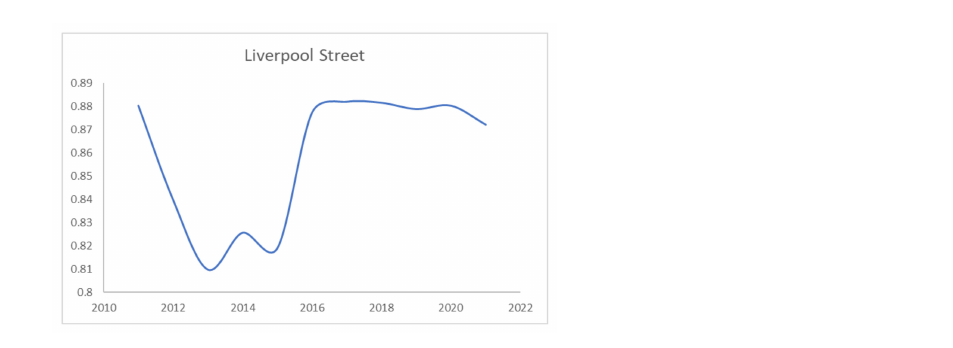
Figure 16. Trend of the reliability of the hot spot strength for shoplifting in the Liverpool Street cluster.